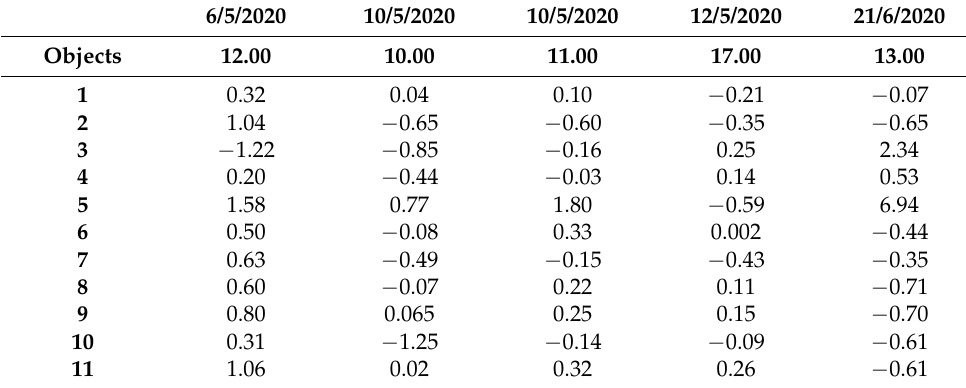
Table A4. Percentage differences of object areas. The positive percentages represent the object areas that are smaller than the reference objects and the negative percentages, the object areas that are bigger than the reference objects. It is observed that eight of the objects have the biggest differences on 06/05/20 and three on 21/06/20. The lowest area differences of seven objects were calculated on 10/05/20 at 10.00, two on 12/05/20, and one on the other dates.